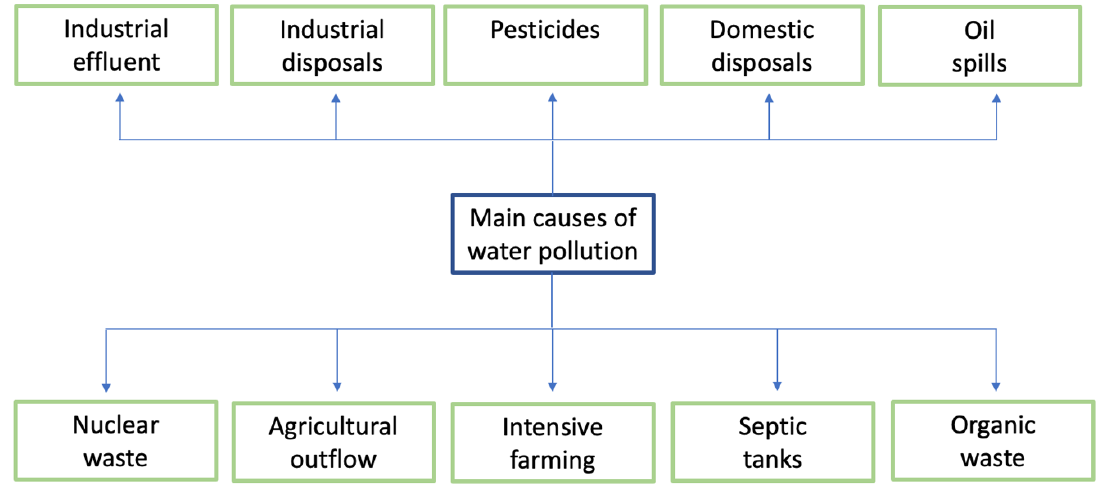
Figure 2. Main causes of water effluent pollution.